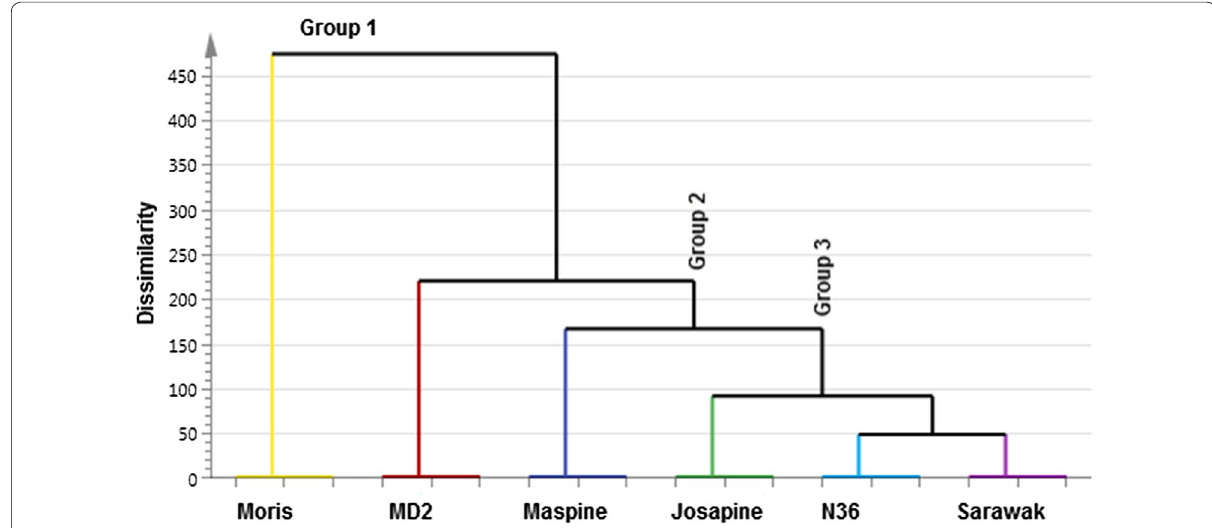
Fig. 3 Dendrogram of hierarchical cluster analysis of six pineapple varieties grown in